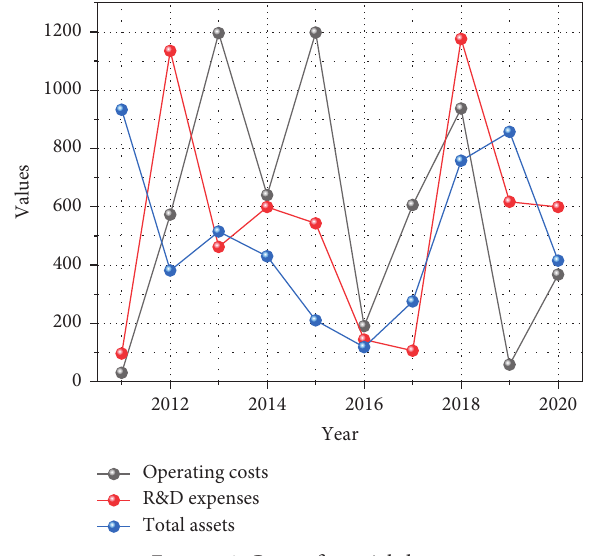
Figure 6: Group financial data.